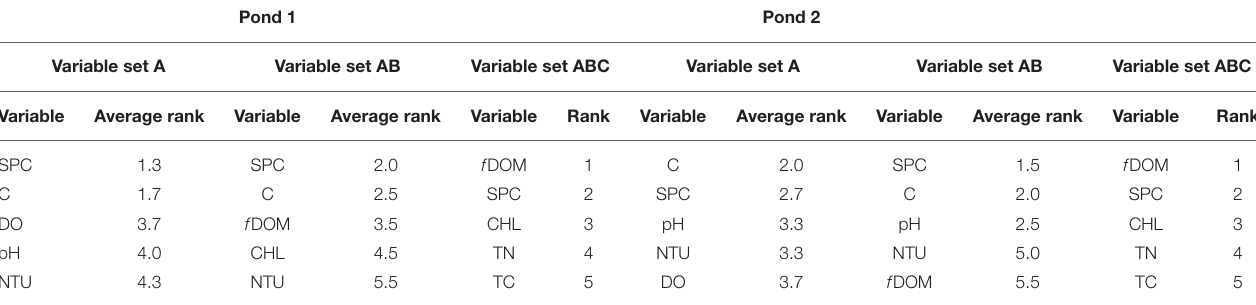
TABLE 2 | The top five important variable as determined by the recursive feature selection algorithm in caret with Random Forests. Pond